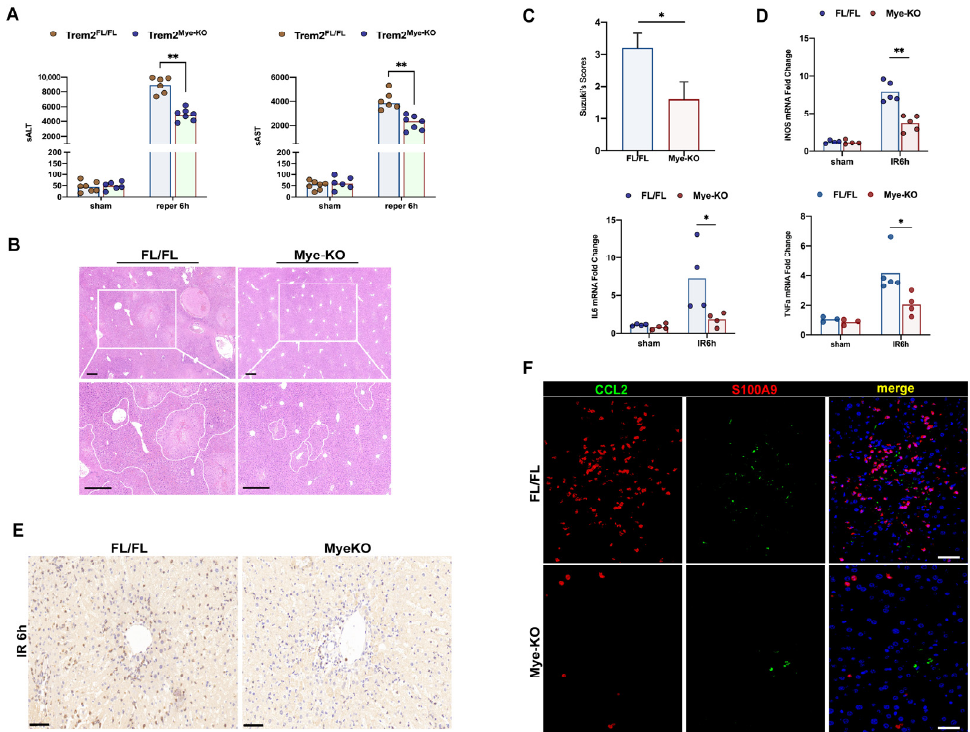
Figure 2. Blockade of myeloid Trem2 attenuated the induction of liver IR injury. ( A ) The levels of serum ALT and AST at sham and IR6h in mice with Trem2 FL/FL or Trem2 mKO were detected ( n = 6–7/group, ** p < 0.01); ( B ) HE staining was used in determining the degree of liver tissue damage caused by IR in Trem2 FL/FL or Trem2 mKO , scale bars = 500 μ m; ( C ) Liver Suzuki’s score was used to analyze the liver tissue injury of Trem2 FL/FL or Trem2 mKO (* p < 0.05, ** p < 0.01); ( D ) Expression of IL6, iNOS, and TNF α in IR6h liver of Trem2 FL/FL or Trem2 mKO by qPCR ( n = 4–5/group, * p < 0.05, ** p < 0.01); ( E ) IHC of Ly6G analyzed neutrophil infiltration in IR livers of mice with Trem2 FL/FL or Trem2 mKO , scale bars = 50 μ m; ( F ) CCL2 and S100A9 were used to analyze the infiltration of immunosuppressive neutrophils in the IR liver of mice with Trem2 FL/FL or Trem2 mKO , scale bars = 100 μ m.